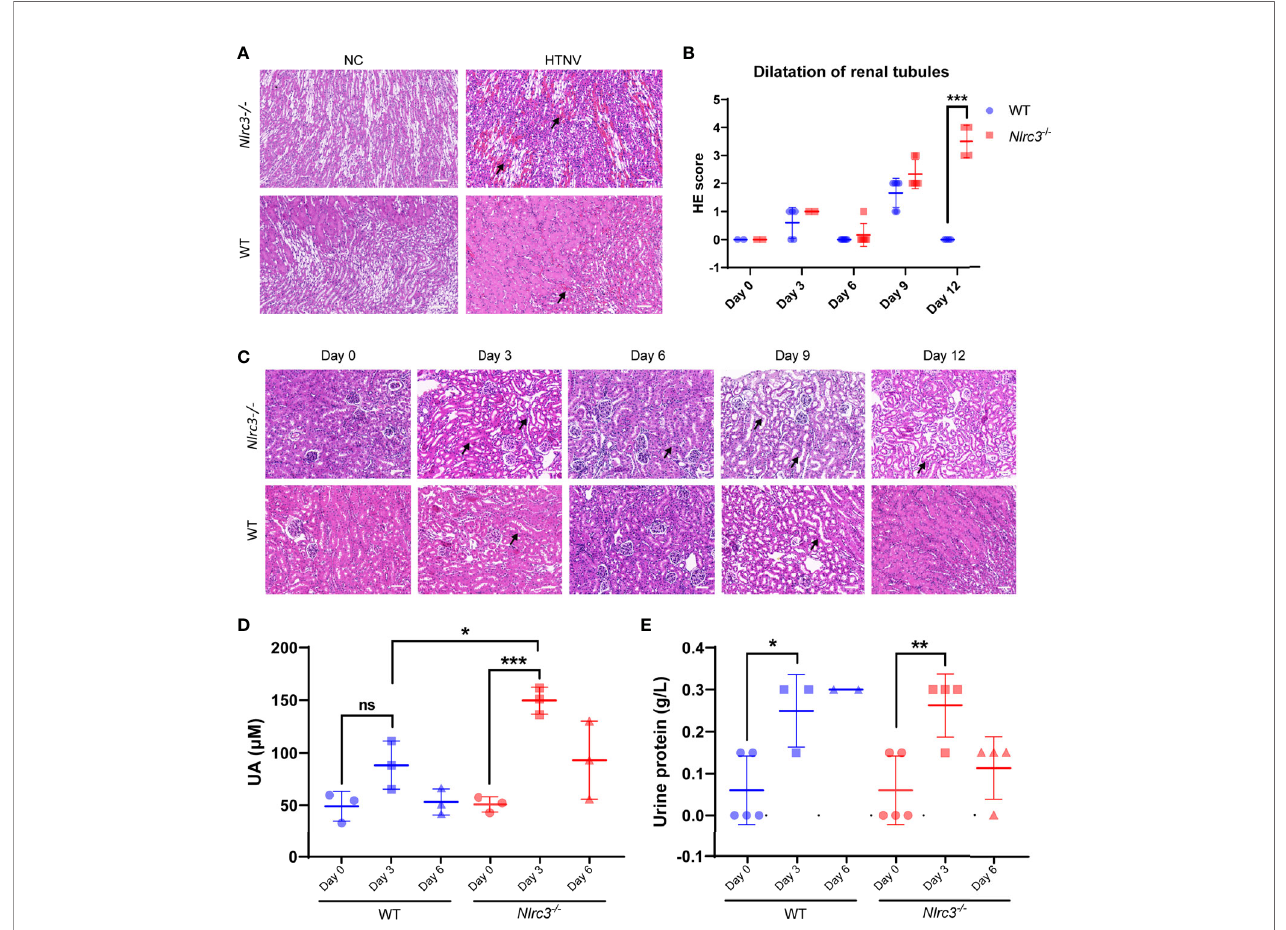
FIGURE 4 | Renal pathological changes in HTNV-infected mice. (A) The kidney was collected on 3, 6, 9, and 12 dpi and fi xed in 4% paraformaldehyde, succumbed to H&E staining. Pathological analysis showing focal hemorrhage (black arrow) in the renal medulla of HTNV-infected mice on 6 days post-inoculation. (B) Statistical fi gure based on histological scores of dilations of renal tubules for Nlrc3 − / − mice (n=6) and WT mice (n=6). (C) Pathological analysis showing extended renal tubules (black arrow) in mice after HTNV infection. H&E images are representative of at least three samples. Scale bars, 50 m m. (D) The whole blood was centrifuged at 1,500 g for 10 mins at room temperature to obtain serum for biochemical detection. The levels of uric acid (UA) in the serum ( m M) of Nlrc3 − / − mice (n=3) and WT mice (n=3). (E) Urine test of Nlrc3 − / − and WT mice post-infection. Urine was collected on days 0 (n=5 in both groups), 3 ( Nlrc3 − / − mice: n=4; WT mice: n=3), and 6 post-infection ( Nlrc3 − / − mice: n=4; WT mice: n=2) for urine routine examination. The level of urine protein of infected mice was quanti fi ed. Bars are means ± SD. *p < 0.05; **p < 0.01; ***p < 0.001; ns is short for no signi fi